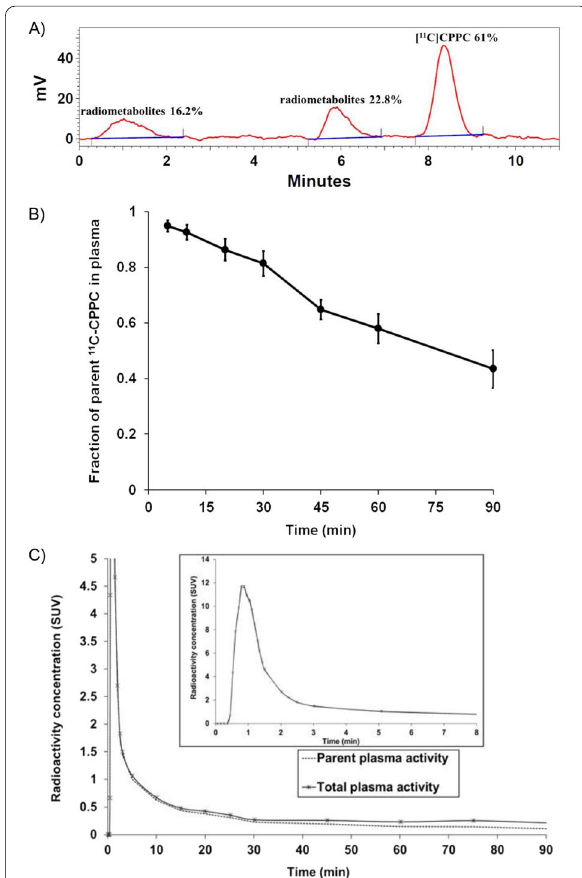
Fig. 1 Plasma activity after injection of 11 C-CPPC. ( A ) HPLC tracing at 60 min post-injection (p.i.) from a representative participant that demonstrates evidence of two radiolabeled metabolites in addition to the peak for parent 11 C-CPPC. ( B ) Parent fraction (mean with standard deviation) measured at select time points (dots) over 90 min p.i., shown with linear interpolation. ( C ) Radioactivity curves in total plasma (solid line) and the portion of unmetabolized 11 C-CPPC (dotted line) p.i. Inset shows early time points. Radioactivity is in standardized uptake value, SUV (injected dose per mL plasma normalized to body weight in grams)